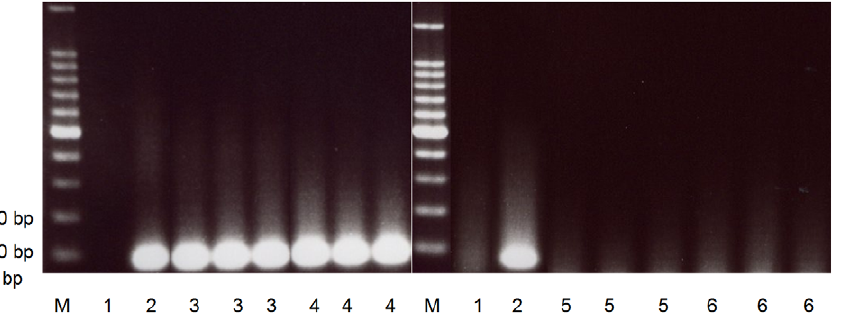
Figure 1. Gel electrophoresis of the stool PCR for water buffaloes targeting the Schistosomajaponicum NAD 1 gene. M , marker. Lane 1 , negative control (stool DNA from non-endemic cattle). Lane 2 , positive control ( S. japonicum adult DNA template). Lane 3–6 , water buffalo stool samples done in triplicates. Positive control, lanes 3 and 4 show positive results with bands at 82 bp while none is seen on negative control, lanes 5 and